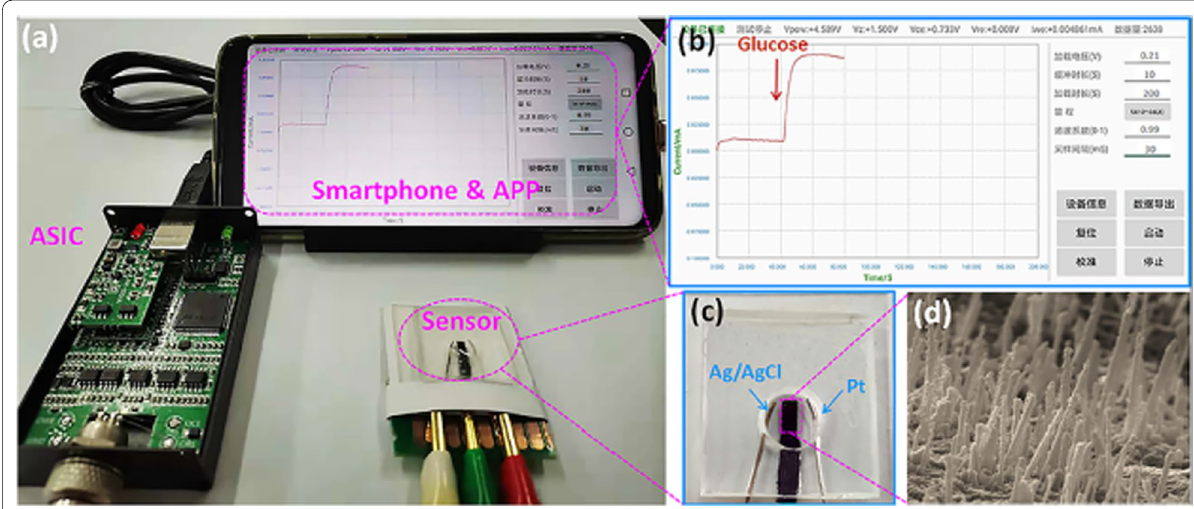
Fig. 2 Picture of the portable electrochemical detection of glucose incorporating with smartphone ( a ); Software interface of APP ( b ); Electrodes setup ( c ); FESEM image of the sensing element gold nanoparticles dispersed on CuO nanowires ( d ) (Zhao et al.